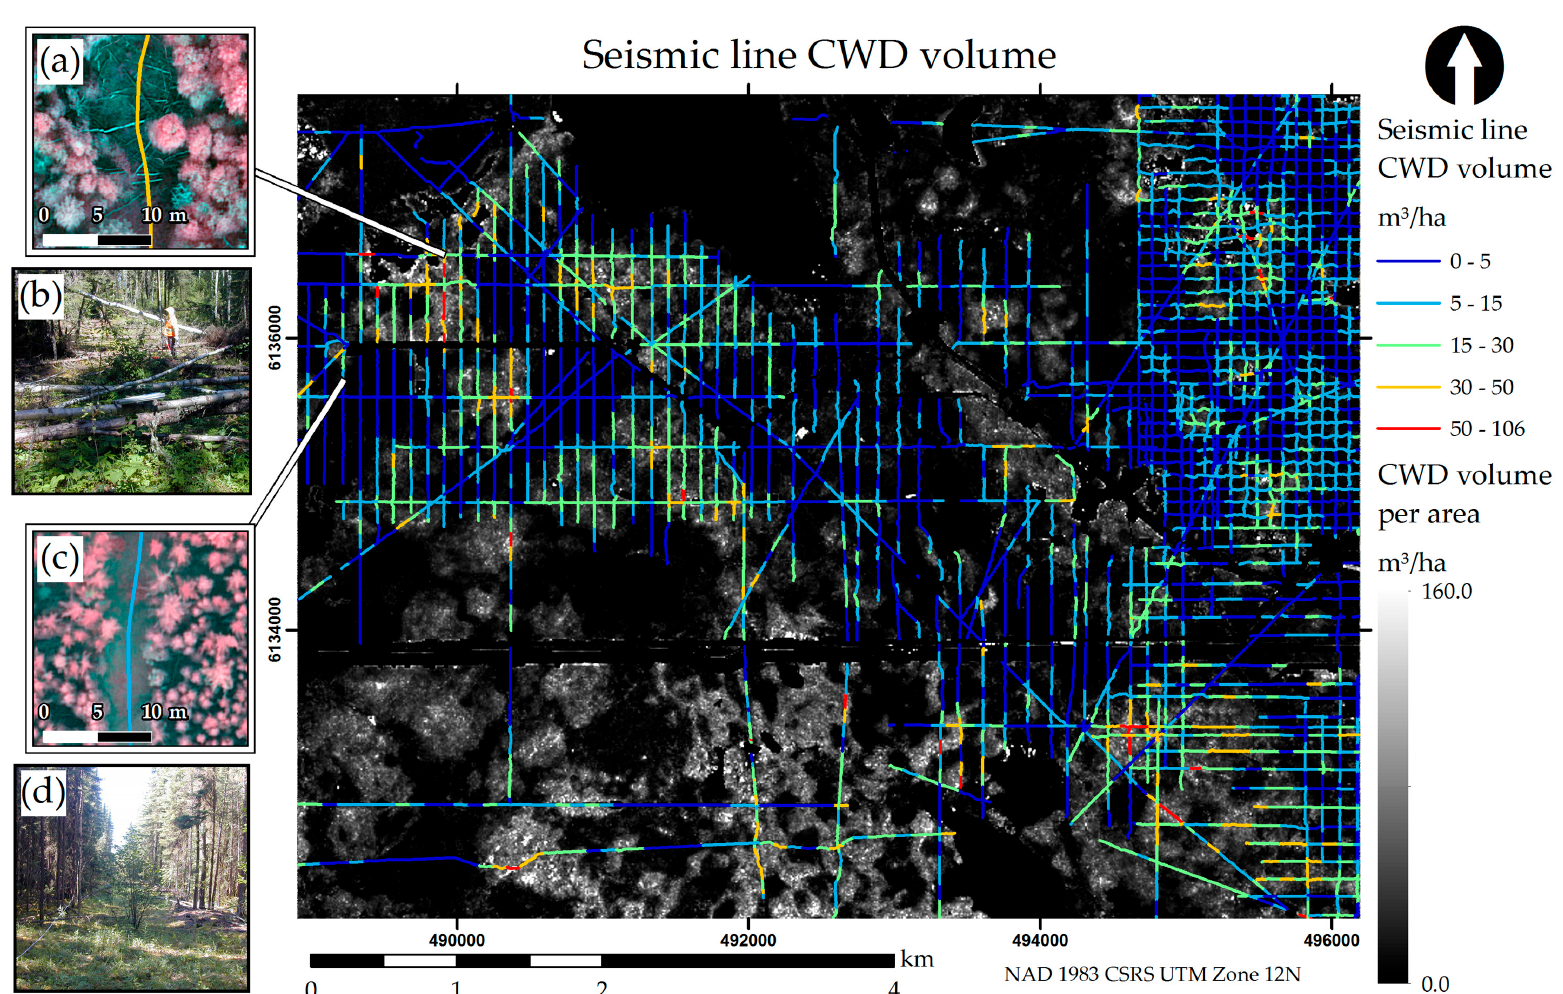
Figure 5. Map of coarse woody debris (CWD) volume per hectare (m 3 / ha) over seismic lines on the study area. The gray-scale background image presents volume per hectare for the entire study area, while the seismic lines are classified as high (red) medium (yellow) and low (blue) CWD quantities. ( a ) and ( c ) are false-color aerial images showing examples of high and low CWD densities respectively. ( b ) and ( d ) are field photos of ( a ) and ( c )